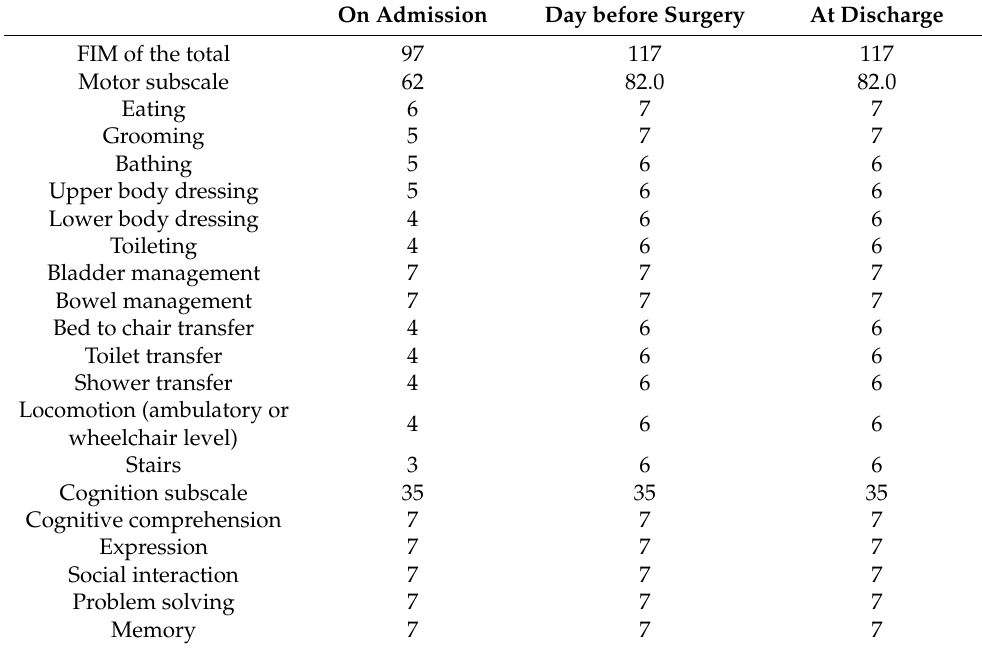
Table 3. Changes in FIM during each